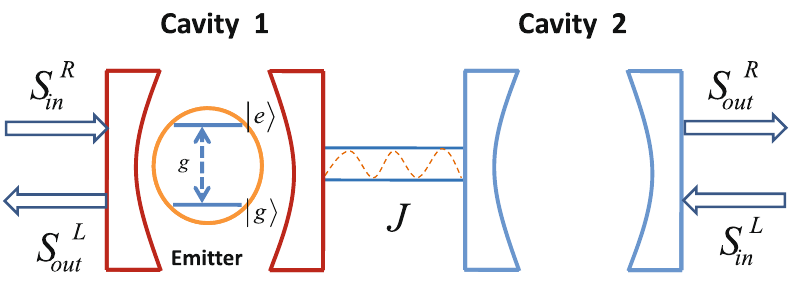
Figure 1. Schematic diagram of the hybrid optical system. The hybrid optical system consists of two coupled cavities and a two-level quantum emitter coupled to one of